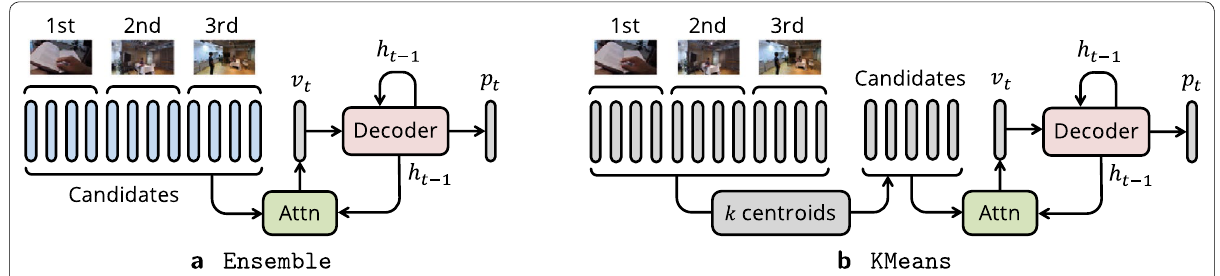
Fig. 4 Proposed methods. a Ensemble is fundamentally equivalent to the baseline UpDown [20]. All salient regions intact are subject to the attention module Att . b In KMeans , a clustering algorithm is applied to salient region features and the k centroid features are subject to